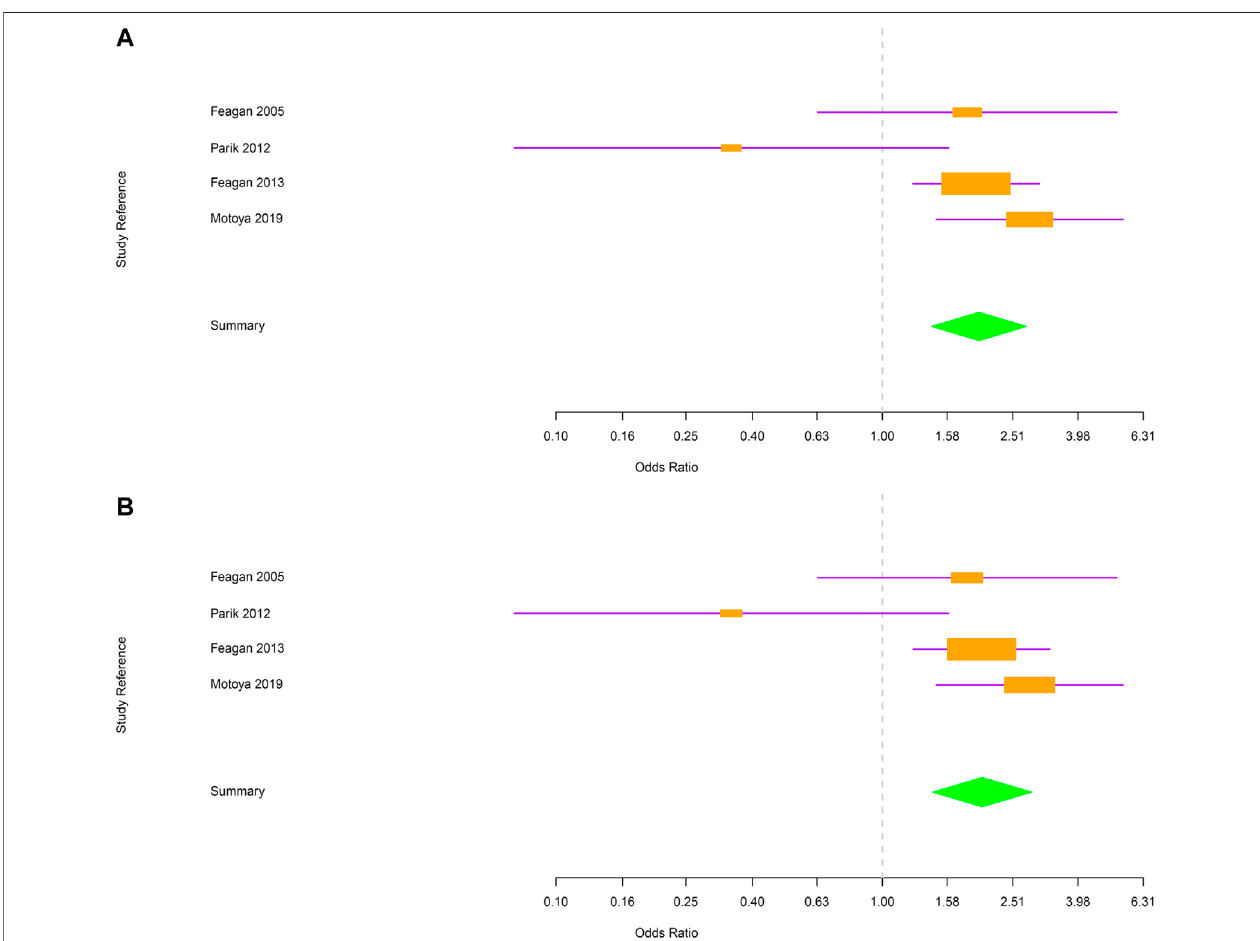
FIGURE 4 | (A) Forest plot for the rate of respiratory tract infections in ulcerative colitis patients. (B) Forest plot for the rate of upper respiratory tract infections in ulcerative colitis patients.